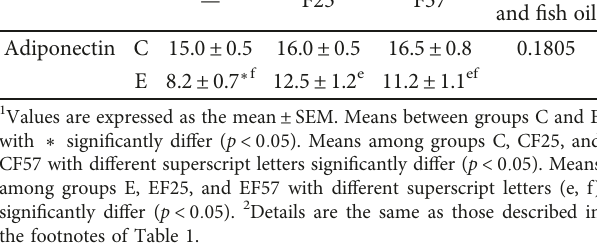
Table 6: Plasma adiponectin levels in each group 1,2 .